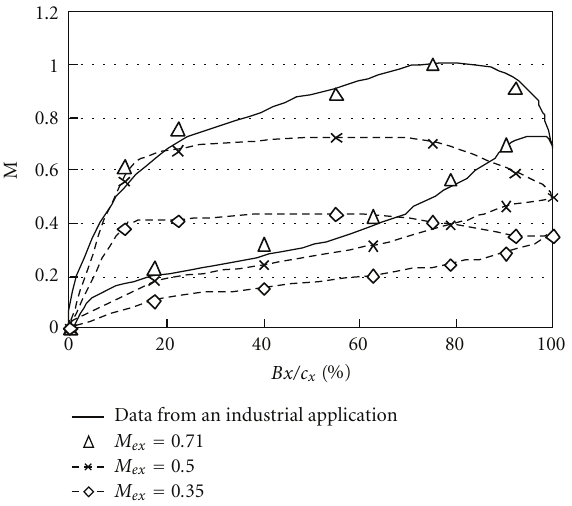
Figure 13: Mach number distributions along the test cambered vane